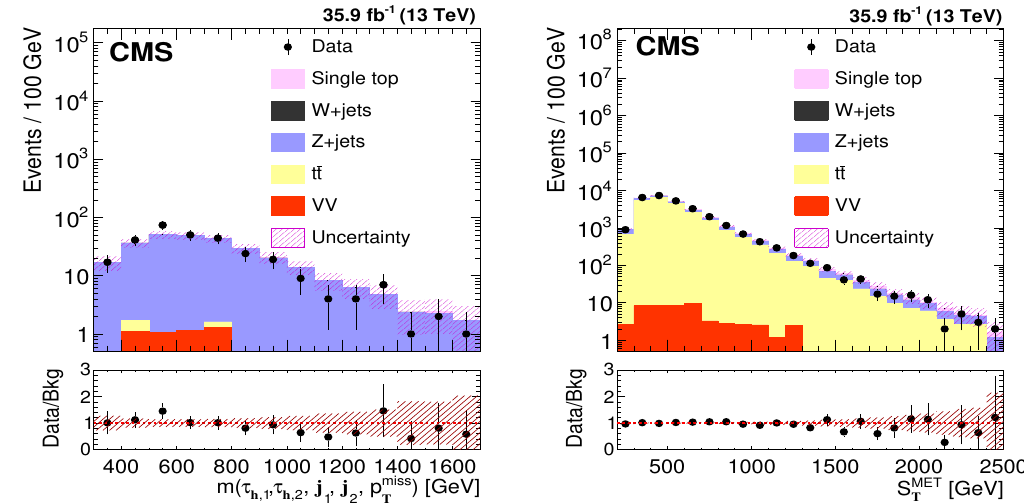
Figure 3 . Distributions in m ( (cid:28) h (cid:28) h candidate p T thresholds and m ( (cid:28) h ; 1 ; (cid:28) h ; 2 ) < 100 GeV, and S MET sample. The bottom frames show the ratio between the observed data in the control samples and the total background (Bkg) predictions. The bands correspond to the statistical uncertainty for the